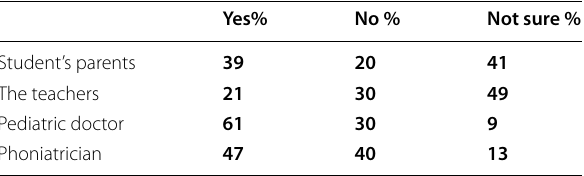
Table 7 Whose job is helping the stutterer as believed by the